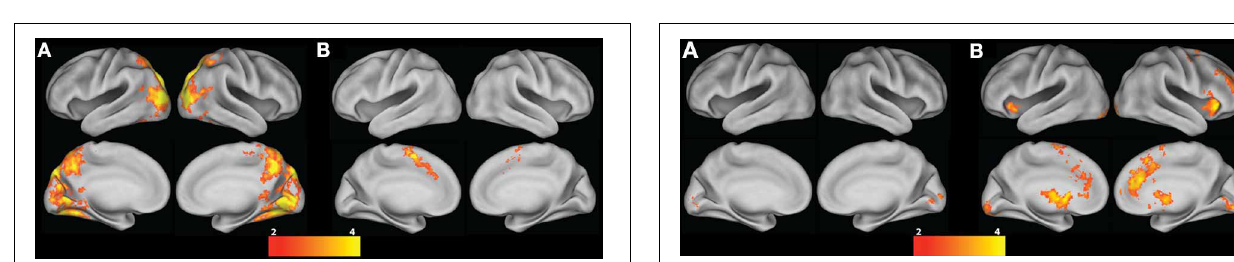
FIGURE 3 | Risky choice contrast. (A) ART vs. BART group contrast; (B) BART vs. ART group contrast. All contrasts are corrected for whole-brain multiple comparisons; statistical maps were projected onto an average cortical surface using CARET (Right hemisphere = Right side of the image). The color scale represents z-score.